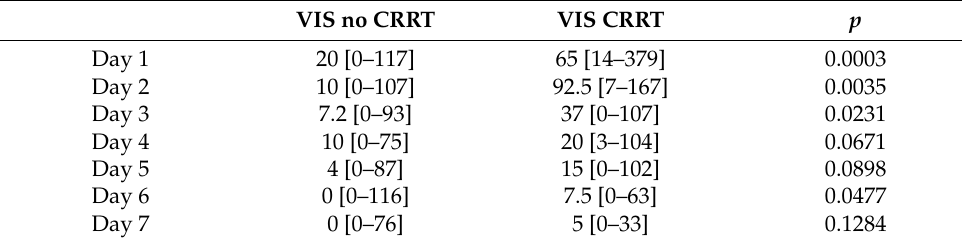
Table 2. Evolution of the VIS as a function of time showing hemodynamic instability in the period of ECMO preceding the initiation of CRRT.